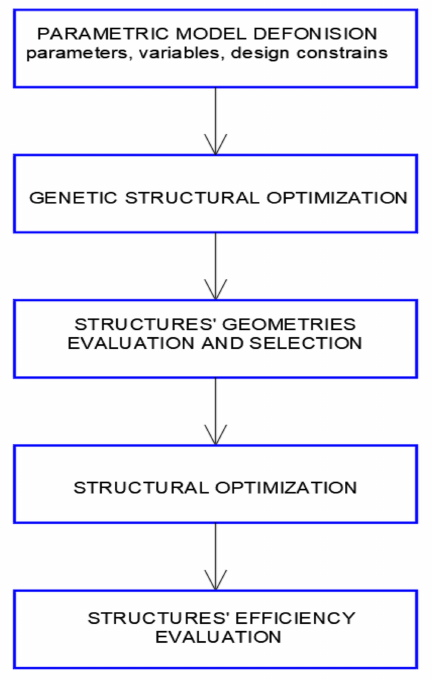
Figure 1. Basic scheme of the integrated shaping